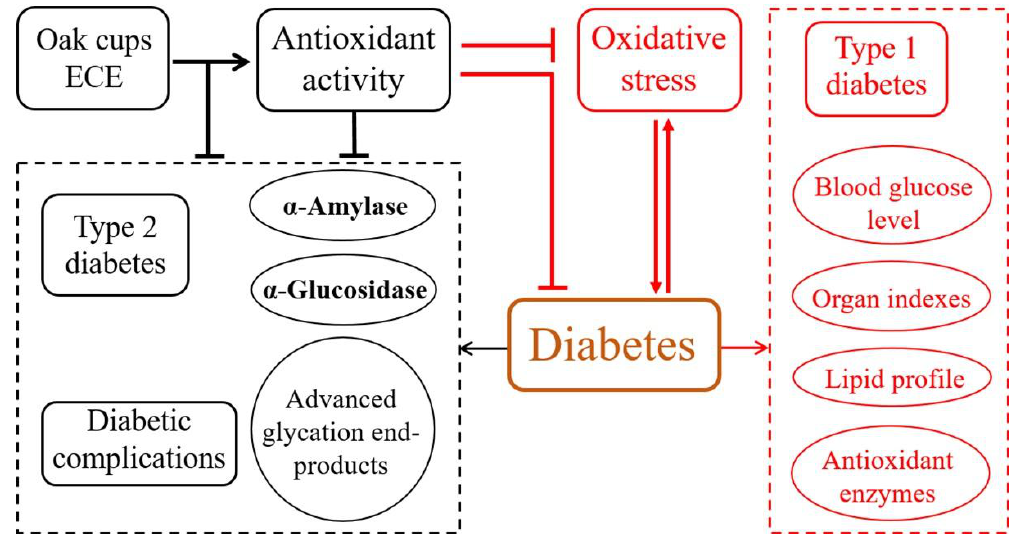
Figure 4. Proposed hypoglycemic mechanisms of ECE prepared from Mongolian oak cups. The proposed mechanism within the black dashed box on the left was summarized based on data of an in vitro study in one of our previous reports [1], and that within the red dashed box on the right was proposed according to the present in vivo investigation.